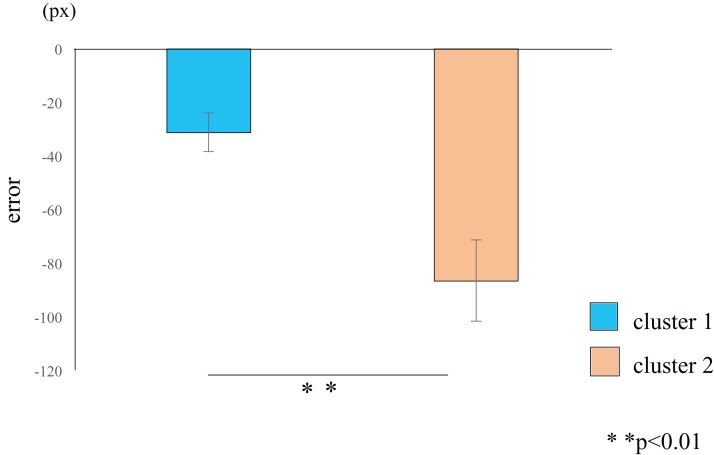
Cluster-wise comparisons of the differences in error values.The difference in the mean errors in cluster 2 (orange) was significantly higher than the difference in the mean errors in cluster 1 (blue), thus demonstrating a learning effect in participants classified into cluster 2. The data represent the means ± standard error. px, pixel.